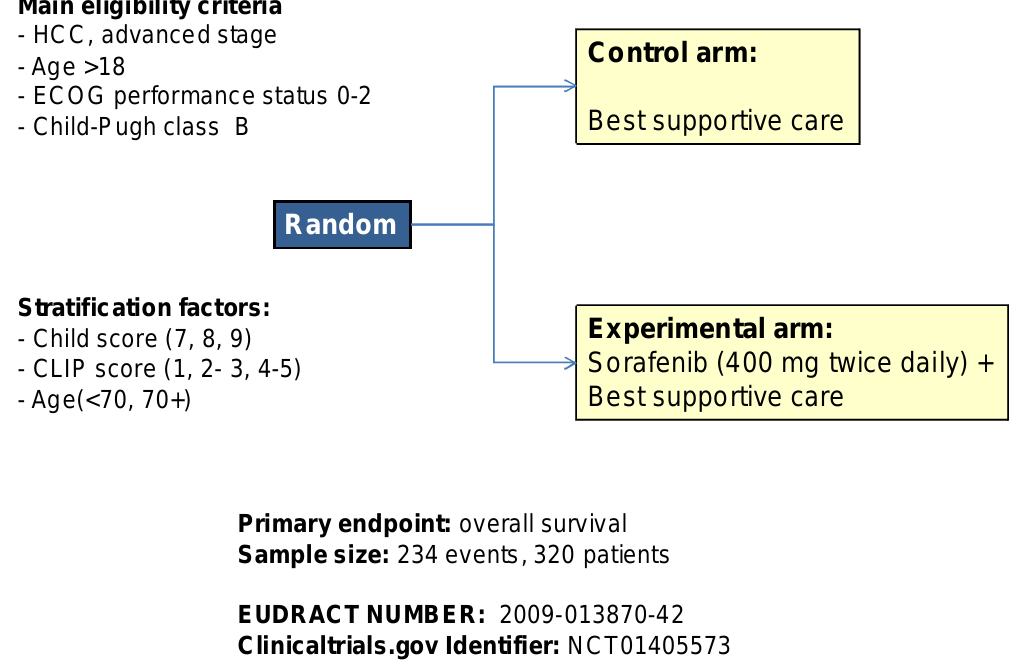
Figure 2. Design of the BOOST randomized phase III trial, comparing sorafenib + best supportive care (BSC) versus BSC alone in Child-Pugh B patients with advanced